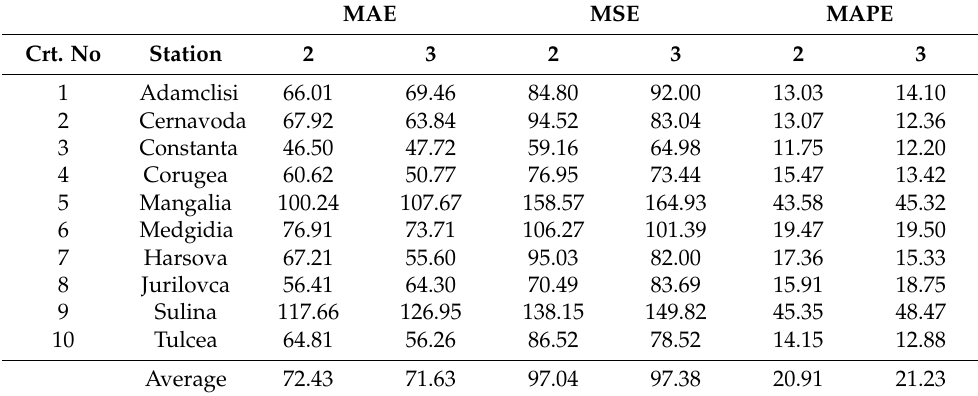
Table 2. The goodness of fit indicators in Methods I with two and three intervals for annual precipitation.